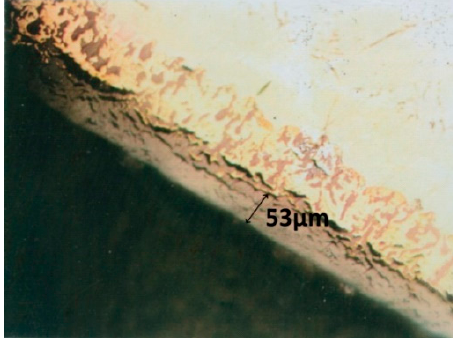
Figure 4. The area with oxynitrides in the corrosion layer after treatment at 951 ◦